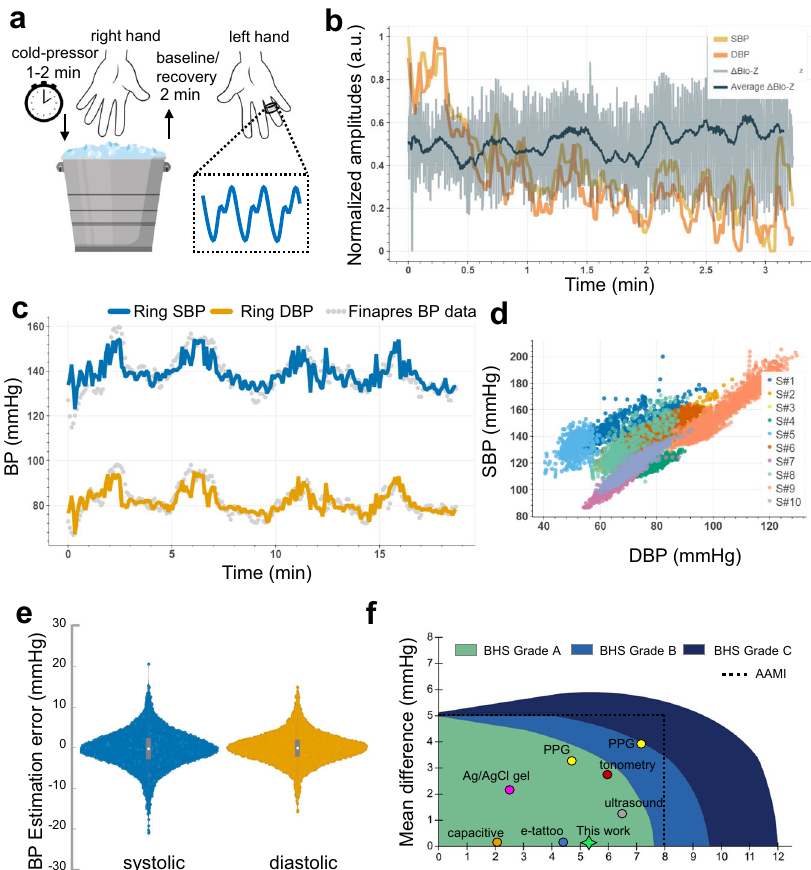
Fig. 7 Bioimpedance ring sensor systolic (SBP) and diastolic (DBP) blood pressure results. a Visualization of cold-pressor test to induce blood pressure variations. b SBP (yellow line) and DBP (orange line) beats, and corresponding bioimpedance signal (gray line) and its mean (dark blue line) for a single trial collected at the participant ’ s recovery from hand-grip/cold-pressor test. c SBP (blue line) and DBP (orange line) estimations with bioimpedance ring sensor in reference to gold-standard Finapres fi nger BP cuff measurements (gray circles) for a single participant (S#3). d SBP and DBP value distributions for all participants, showing the wide range of blood pressure values used in evaluation. Colors represent data from different participants. e Violin plots for SBP (blue) and DBP (orange) estimations errors with ring sensors in comparison to reference Finapres BP. The gray box plot shows the median, and 25th and 75th quartiles. f Comparison of related work with this work for cuf fl ess BP estimation and their classi fi cation based on the AAMI and BHS standards. Green, light blue, and dark blue areas represent Grade A, Grade B, and Grade C classi fi cations for the BHS standard. Dashed black line represents the error limits set by the AAMI